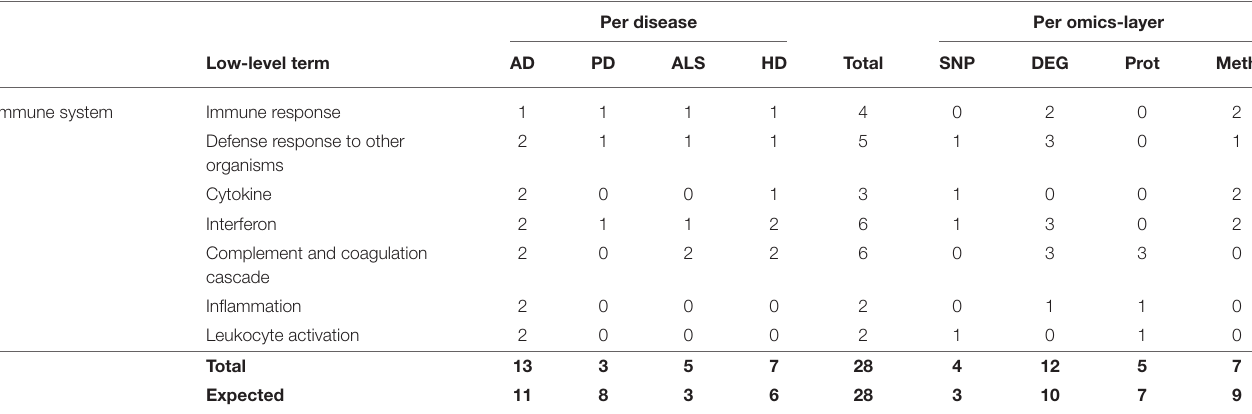
TABLE 7 | Accumulated number of low-level terms per NDD and per omics-layer for the hallmark Immune System. Per disease Per omics-layer Low-level term AD